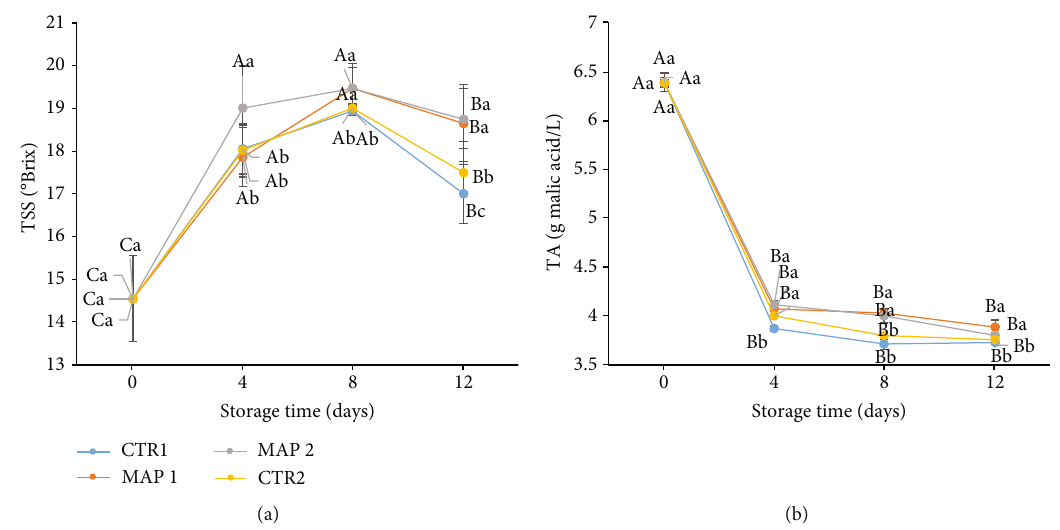
Figure 2: Pomological traits of mulberry fruit at 0, 4, 8, and 12 days of storage at 4 ± 1 ° C and 90 ± 5 % RH (relative humidity) after all treatments. (a) TSS, ° Brix. (b) TA, g malic acid/L. Means ± SD with di ff erent letters are signi fi cantly di ff erent at p ≤ 0 : 05 using Tukey ’ s HSD test. Di ff erent capital letter denotes signi fi cant di ff erences ( p ≤ 0 : 05 ) among di ff erent treatments for the same sampling time. Di ff erent lowercase letter denotes signi fi cant di ff erences ( p ≤ 0 : 05 ) among di ff erent treatments for the same sampling time. Letter “ a ” or “ A ” denotes the highest value. Di ff erent capital letters denote signi fi cant di ff erences ( p ≤ 0 : 05 ) among di ff erent sampling times for the same